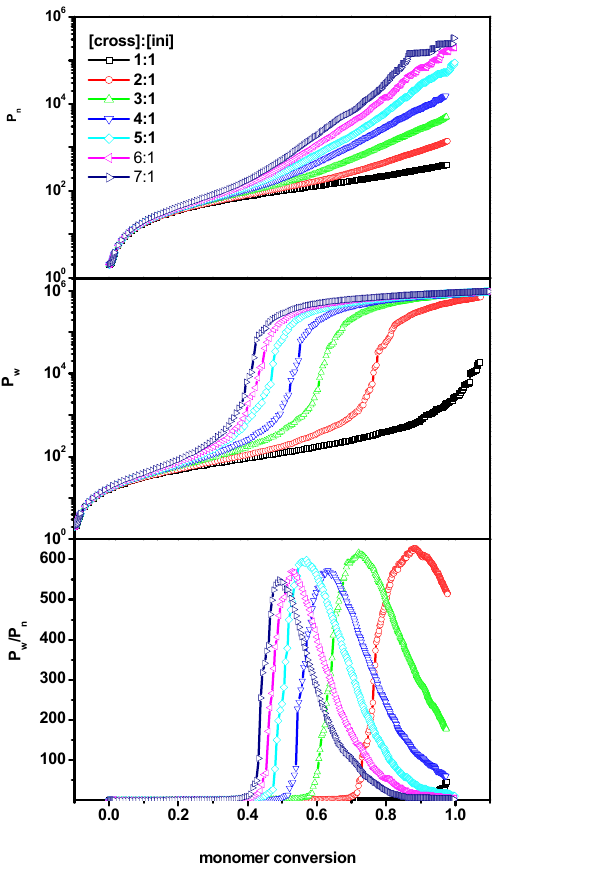
Figure 2. The number-average chain length ( P n ) ( upper ), the weight-average ( P w ) ( middle ) and the dispersity ( P w / P n ) ( lower ) vs. monomer conversion for the initiator concentration 0.6%. The case of the slit (system B) with the distance between walls d = 100 ( left panel) and d = 10 ( right panel). The values of the ratios [Ini]/[X] are given in the insets to the upper